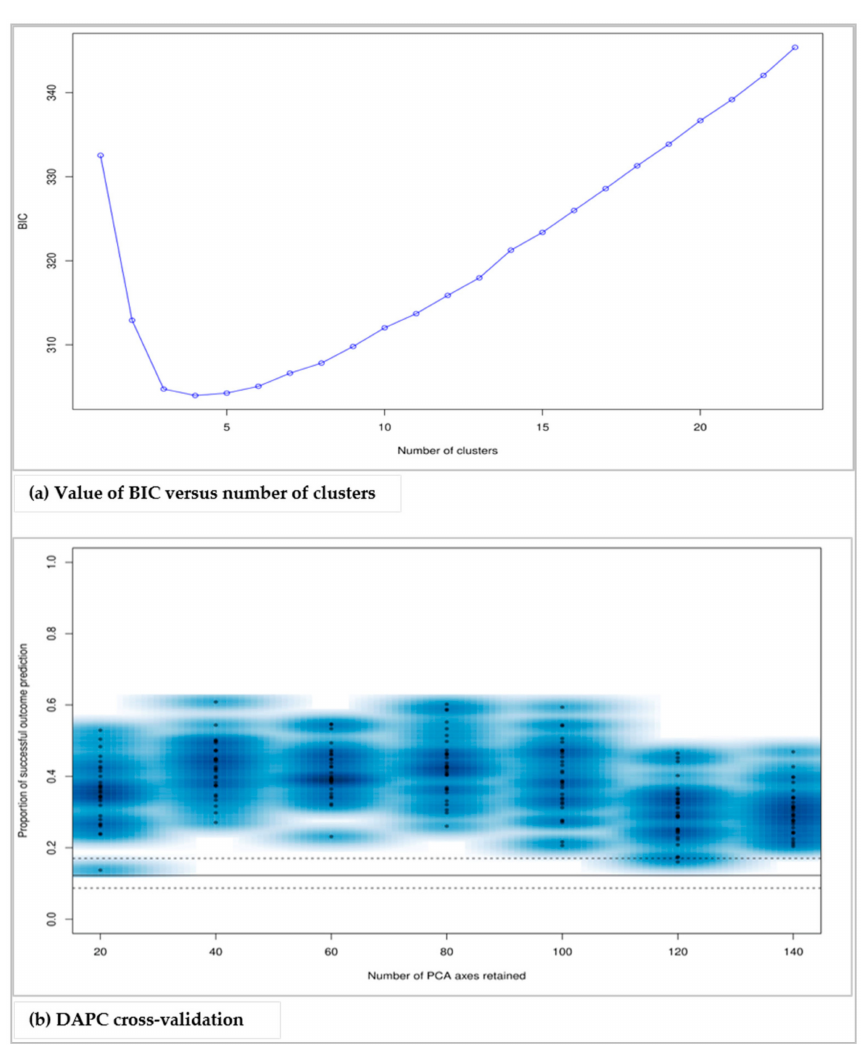
Figure 3. Determination of the optimum number of clusters ( a ) and number of principal components (PCs) and discriminant functions to be retained in the discriminant analysis of principal components (DAPC) analysis ( b